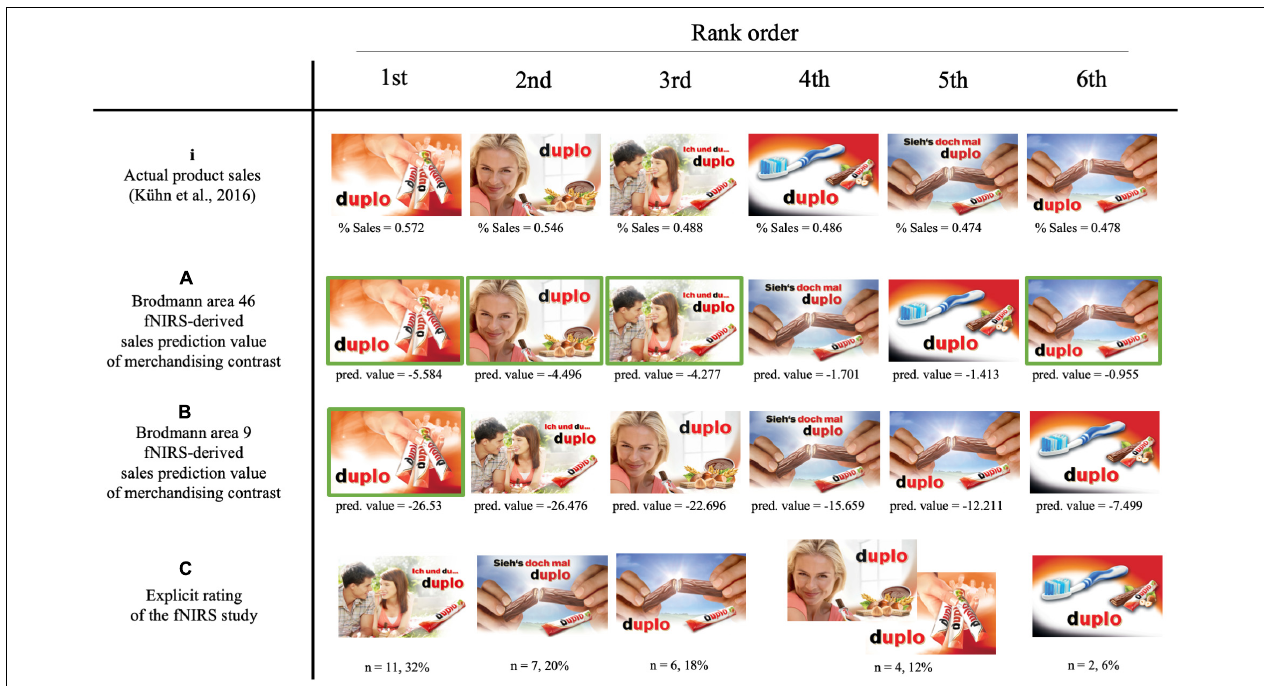
FIGURE 7 | Ranking of the six merchandising elements. (i) The rank order based on actual sales data from Kühn et al. (2016). Rank order of the merchandising elements derived from fNIRS-derived sales prediction value of (A) Brodmann area 46 and (B) Brodmann area 9 as well as the (C) explicit subjective rating of the participants in the fNIRS study. The fNIRS-derived sales prediction values and percentages are displayed underneath the merchandising element. Matched rank order positions are marked in red. Figure partly adapted from Kühn et al. (2016). Permission to reuse has been obtained.